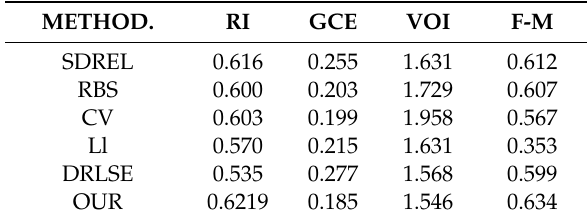
Figure 7. The first row consists of the original images. The second row demonstrates the object contours of the SDREL model, the third row gives the SDREL salience results, the fourth row shows the contours of LFE, the fifth row shows the salience results of the LFE model, the sixth row shows the contour of the LI model, and the salience results are in the seventh row. The eighth row shows the contour results of our algorithm, and the final salience is in the last row. Table 1. Statistical Results of Evaluation on the MSRA-1000